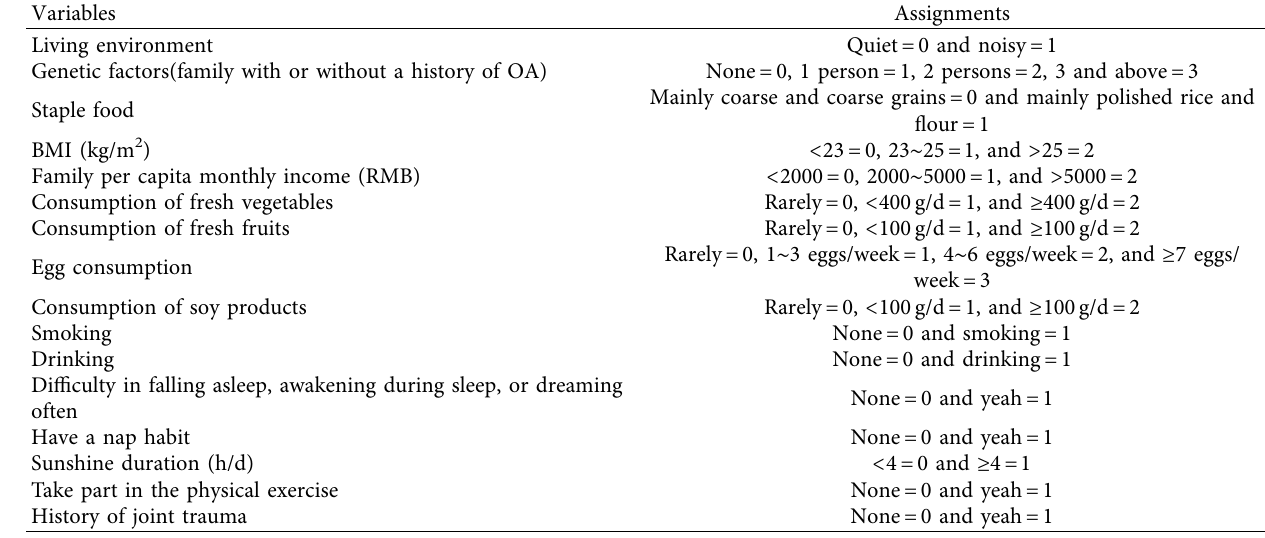
Table 1: The assignment of each study